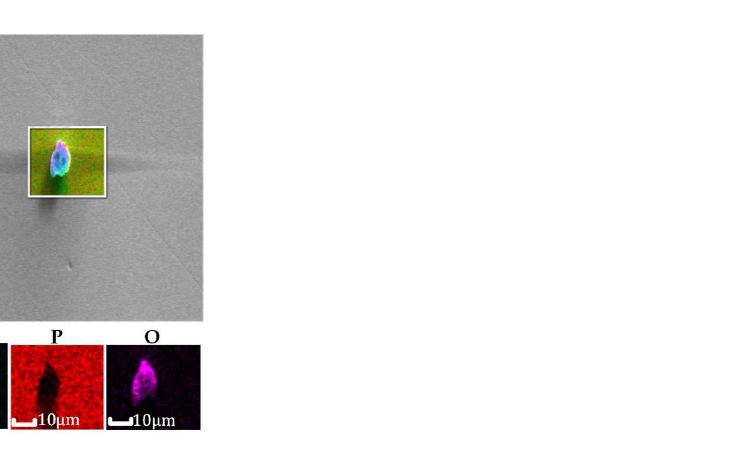
Figure 14. Measurement of impurities on the surface of a modified layer.